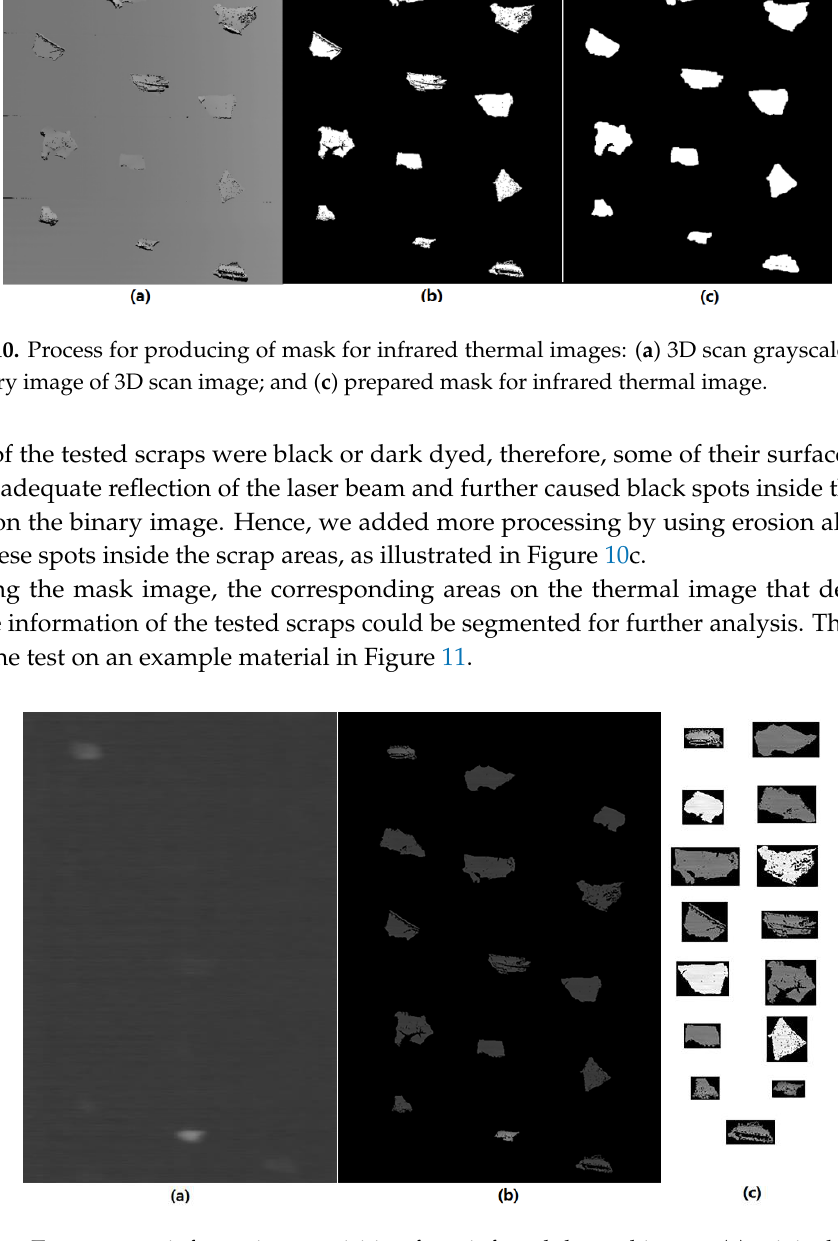
Figure 10. Process for producing of mask for infrared thermal images: ( a ) 3D scan grayscale image; ( b ) binary image of 3D scan image; and ( c ) prepared mask for infrared thermal image.